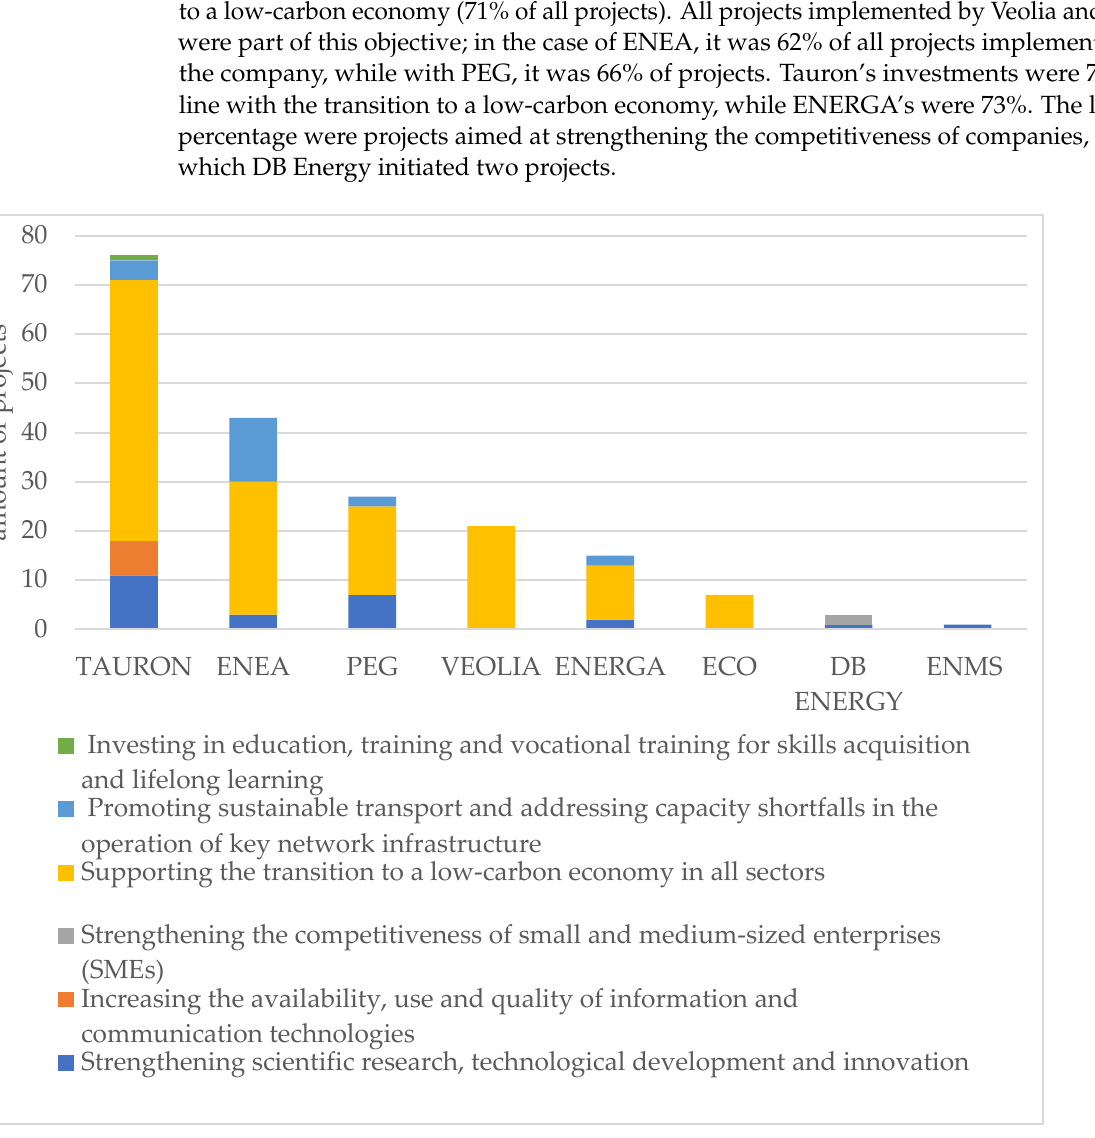
Figure 4. Share of energy company implemented projects by cohesion policy objective. Source: own compilation based on data from www.funduszeeuropejskie.pl (accessed on 10 March